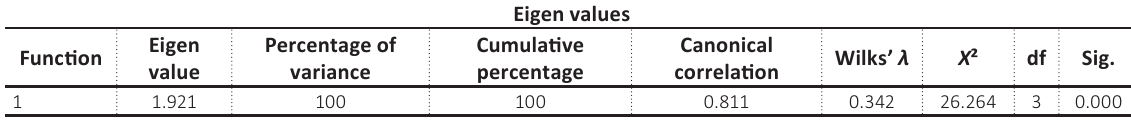
Table 3. Outline of canonical discriminant functions ( t